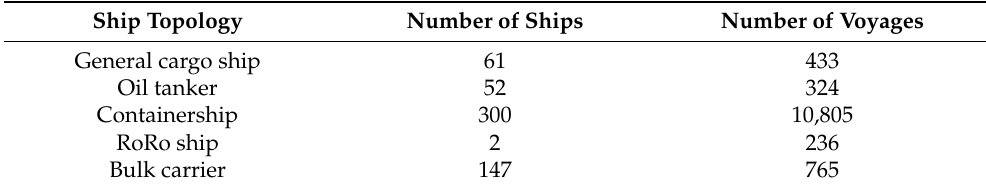
Table 3. Ship topologies considered to generate the training set and the associated number of ships and